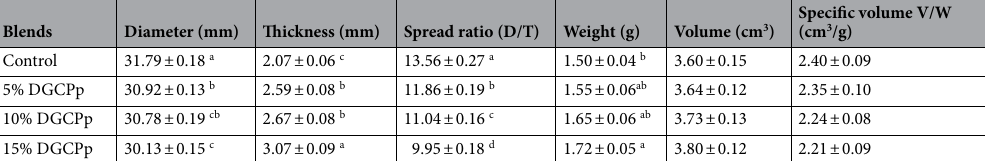
Table 4. Physical properties of crackers. Data are expressed as mean ± SEM. Mean values with different superscript letters [a (the highest values)—c (the lowest value)] in the same column are significantly different at ( p ≤ 0.05). All groups were compared to each other.